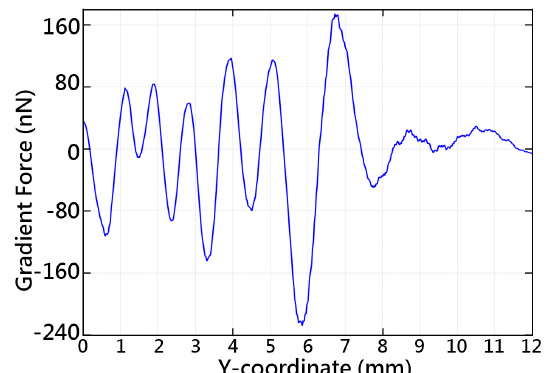
Figure 7. Simulated gradient force along the central axis of the acoustic tweezers.